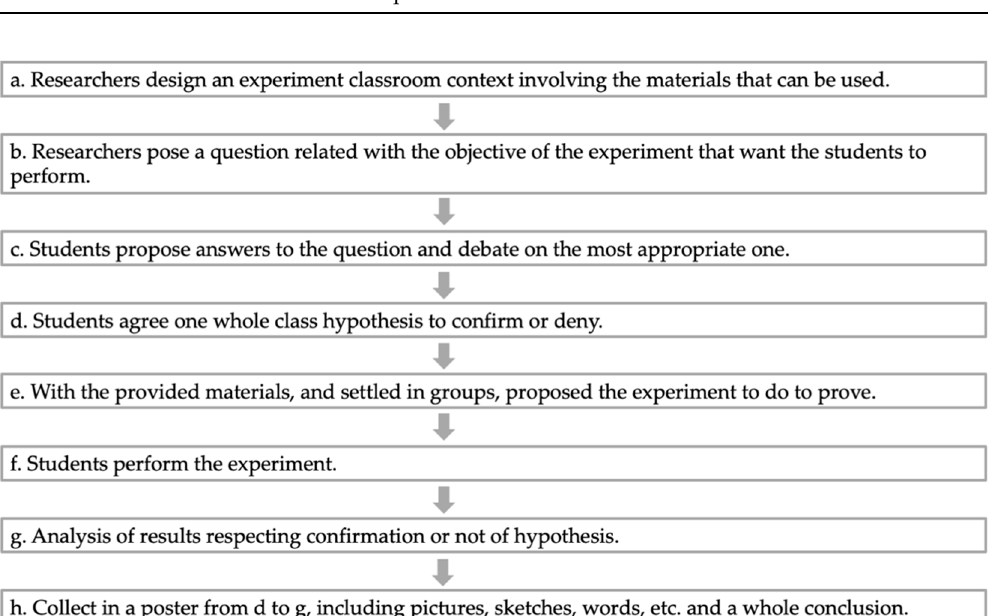
Figure 1. Intervention procedure.